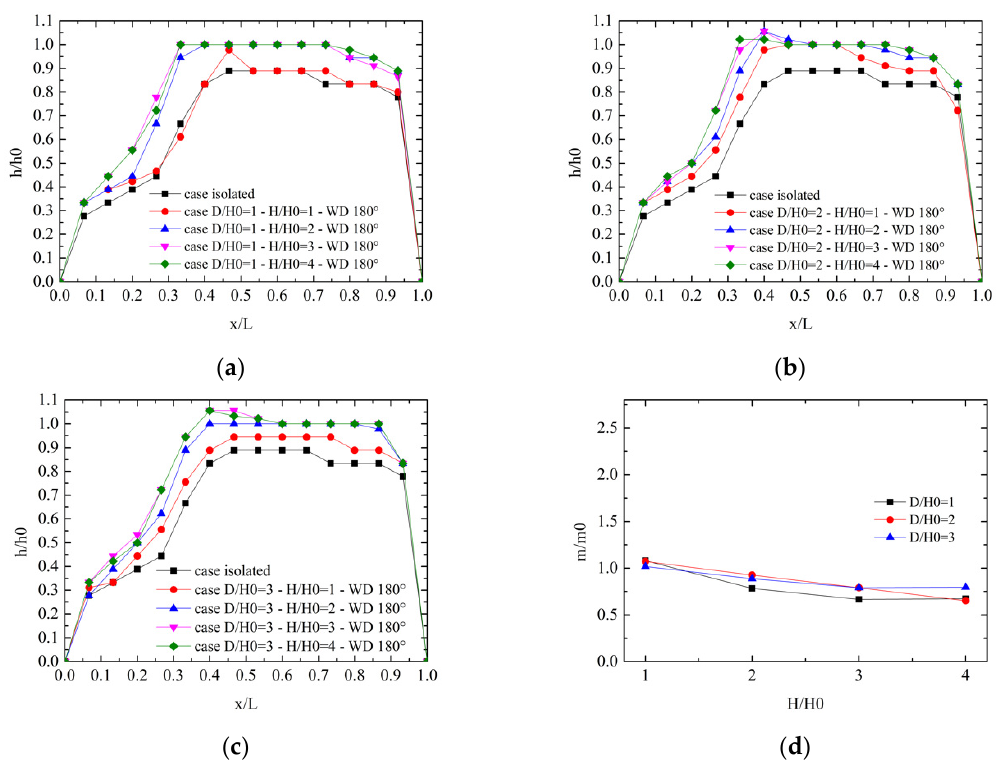
Figure 7. Normalized snow depth of the central line on the target building under the 180° wind direction: ( a ) building